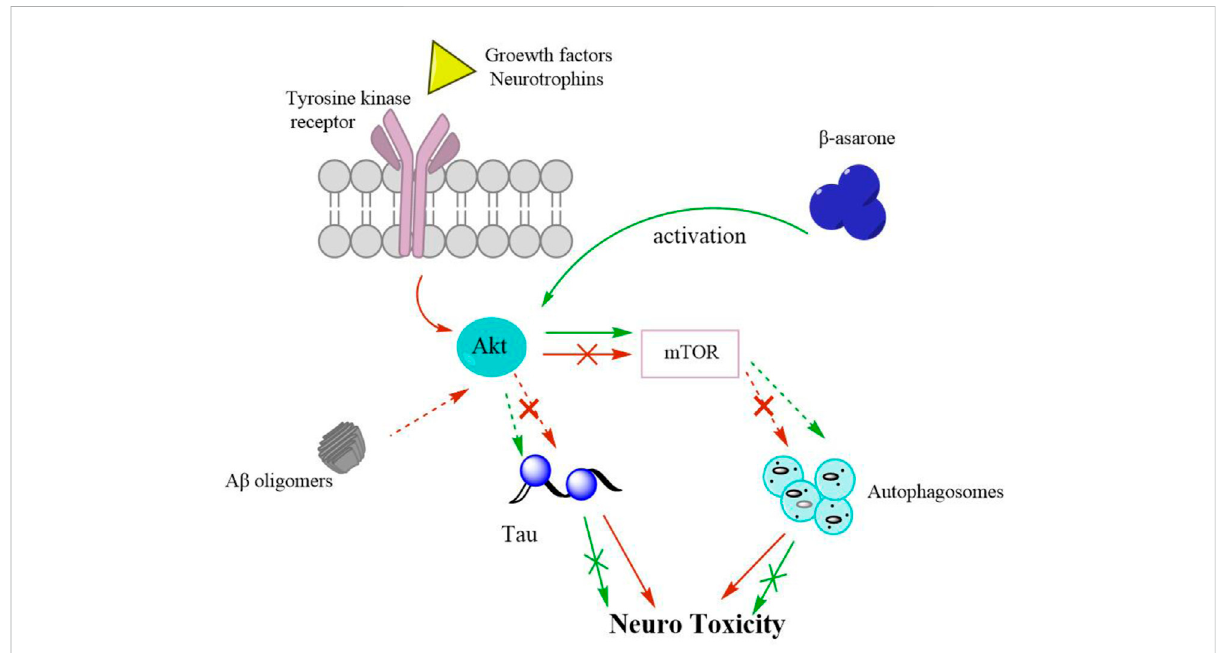
FIGURE 3 A schematic diagram shows that β -asarone protects cells from A β 1-induced cytotoxicity by activating Akt-mTOR signaling pathway. Arrows, activation;Discontinuouslines, inhibition; Red, A β -induced cytotoxicity; Green, therapeutic mechanism of β -asaroneon AD by activating Akt/mTOR